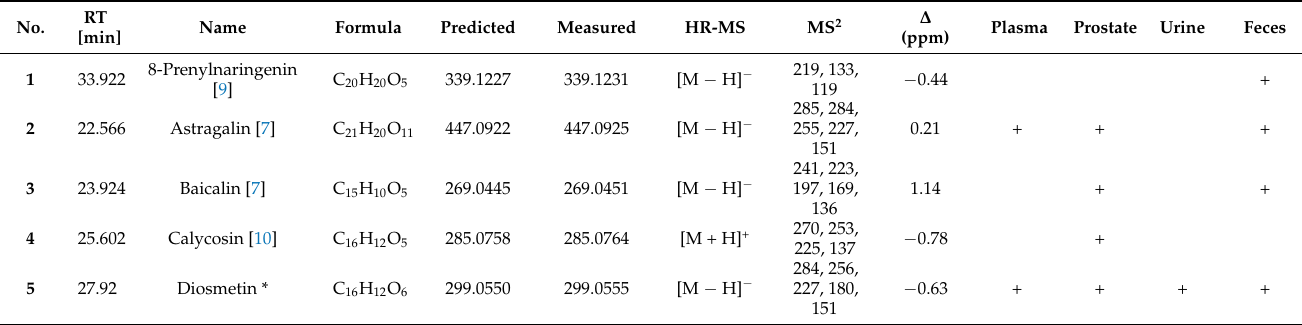
Table 1. Distribution of protoflavones in biological